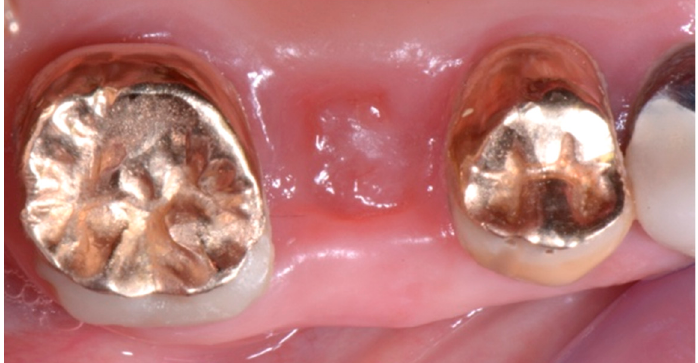
Figure 9. Complete re-epithelization of the surgical site after 2 months from the intervention.